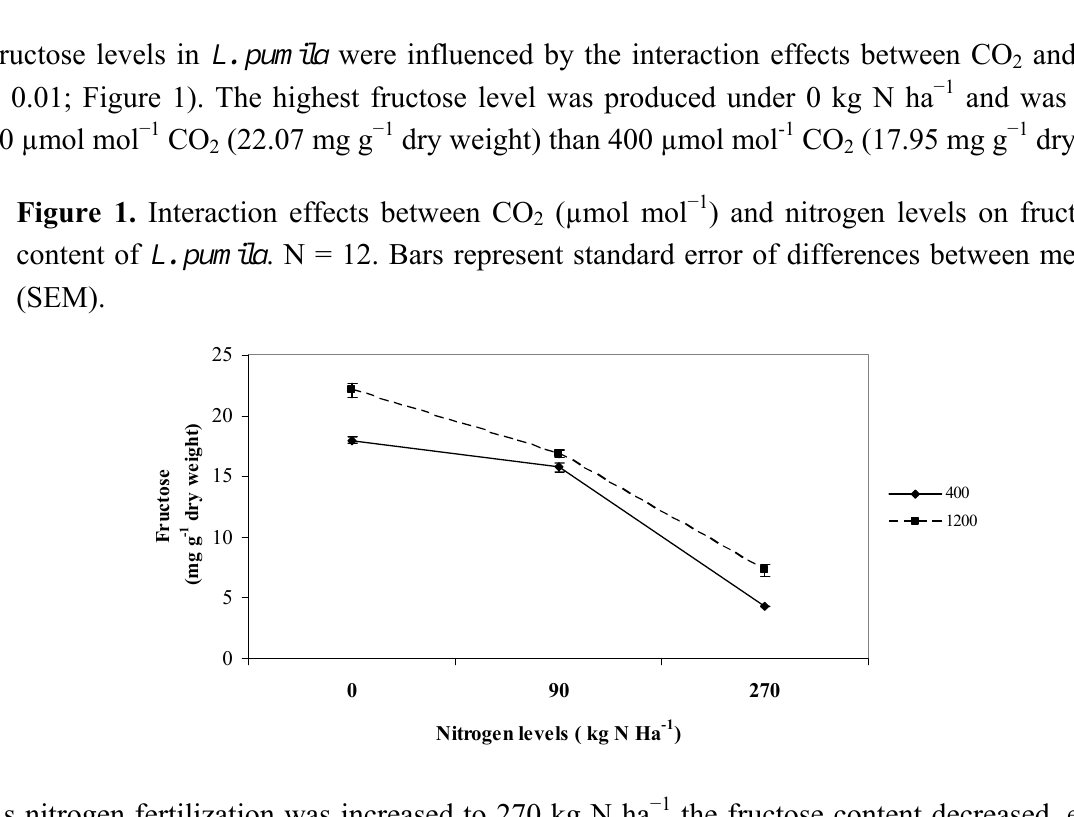
(µmol mol − 1 ) and nitrogen levels on fructose 2